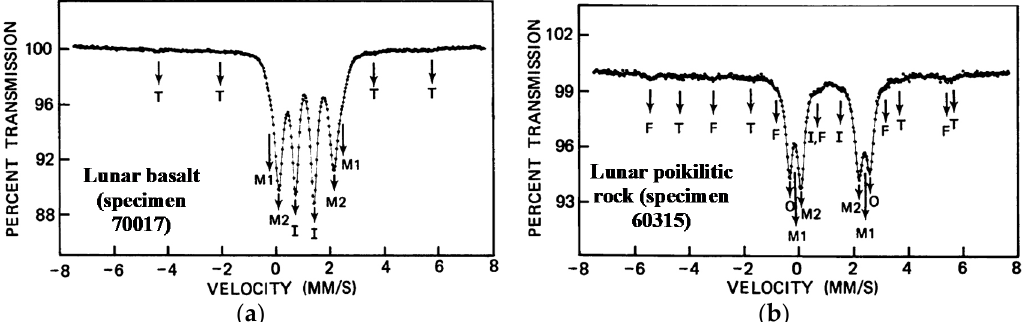
Figure 44. Mössbauer spectra of Lunar samples measured at room temperature: basalt, specimen 70017 ( a ) and poikilitic rock, specimen 60315 ( b ). F is metallic iron alloy, T is troilite, O is olivine, M1 represents the M1 sites in pyroxene, M2 represents the M2 sites in pyroxene, and I is ilmenite. Adapted from [107].